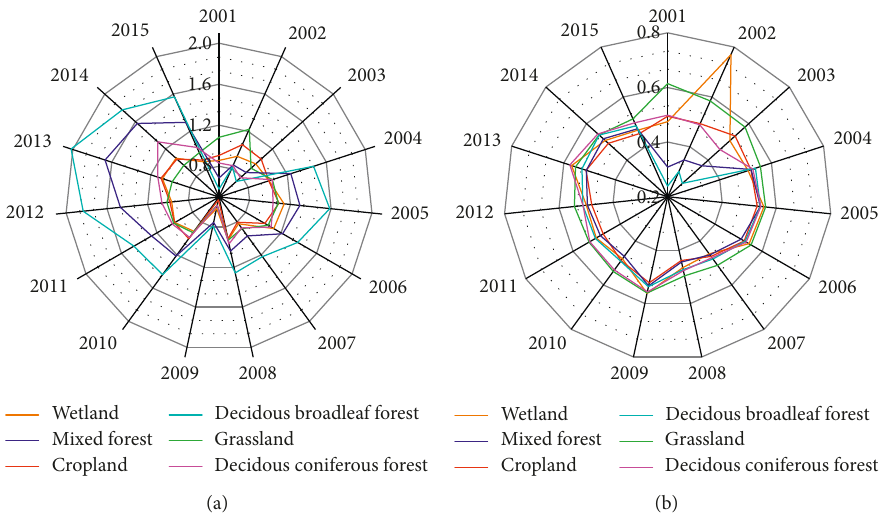
Figure 3: WUE (a) and CUE (b) of different ecosystems in the SNP from 2001 to